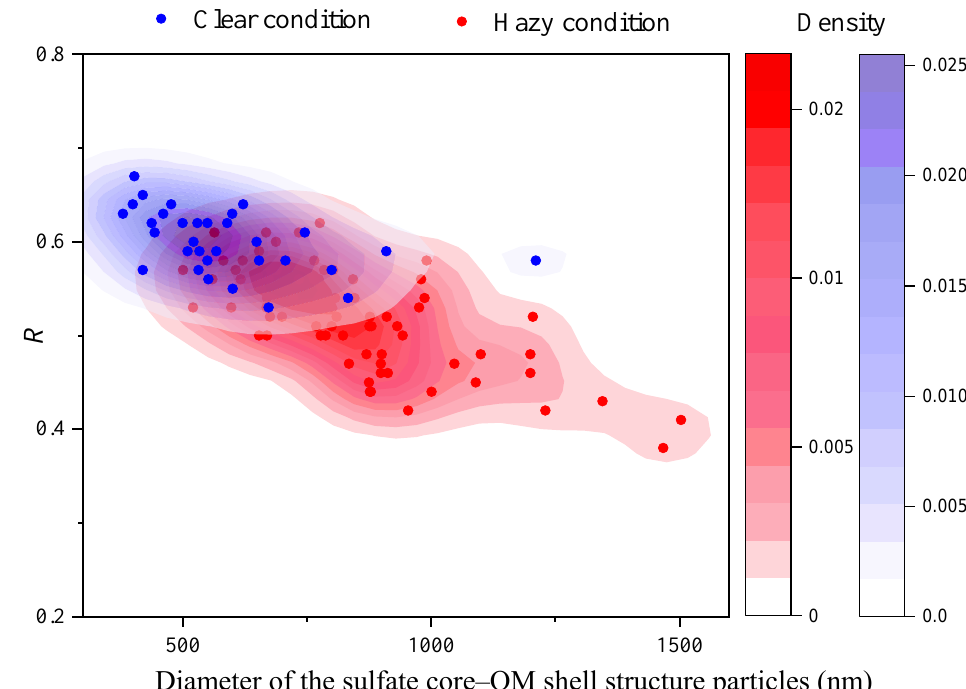
Figure 6. The ratio of the core diameter to the whole particle diameter ( R ) and its density of the sulfate core–OM shell structure particles under clear and hazy conditions. The number of the sulfate core–OM shell structure particles is from the whole set of samples for each case.